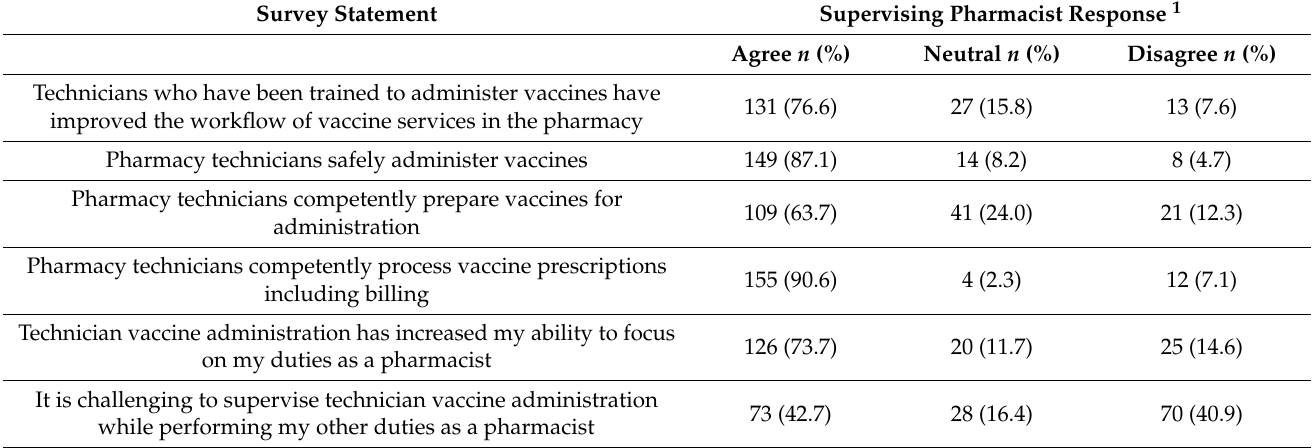
Table 2. Supervising pharmacist survey response result summary ( n =